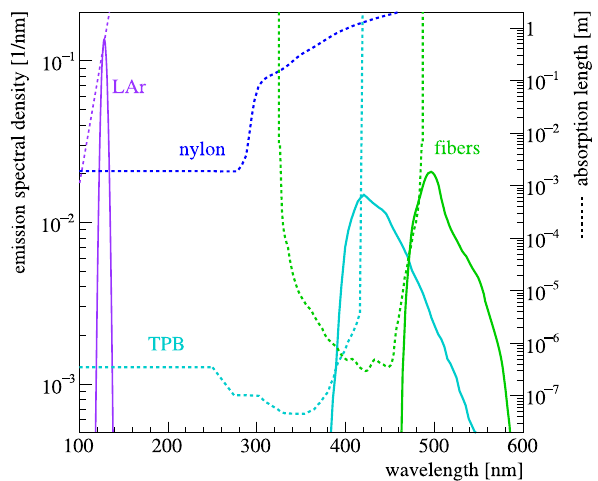
Fig. 3 Emission spectra (solid lines) and absorption length (dashed lines) of indicated materials. The primary emission from the LAr fol- lows a simple Gaussian distribution centered at 128 nm. Its absorption length connects to larger wavelength with an ad-hoc exponential scal- ing. Absorption and re-emission appears in TPB and the polystyrene fiber material. Nylon is only transparent to larger